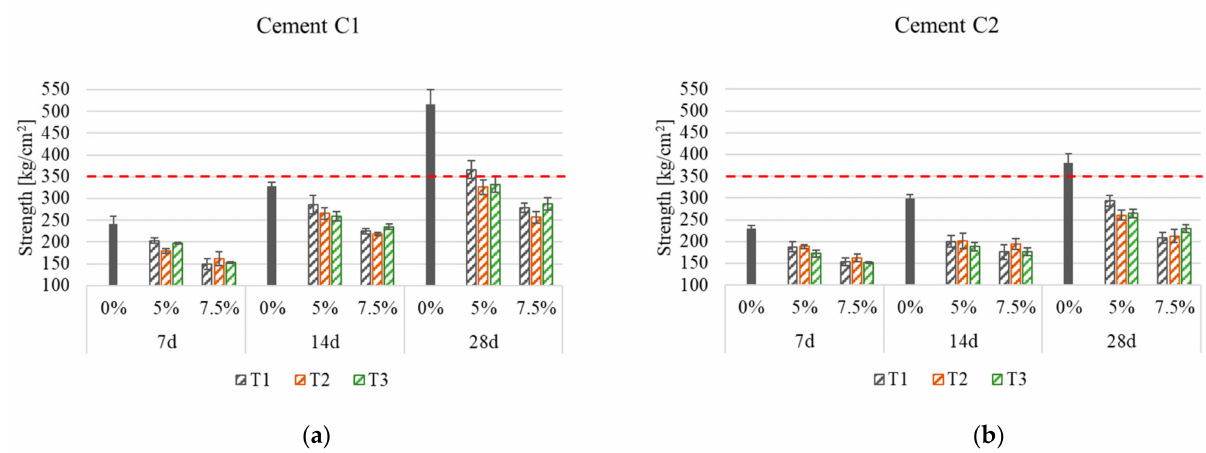
Figure 14. Compressive strength of rubber-added mortar samples with addition of untreated rubber at 5% and 7.5% replacement, aged 7, 14, and 28 days: ( a ) cement C1; ( b ) cement